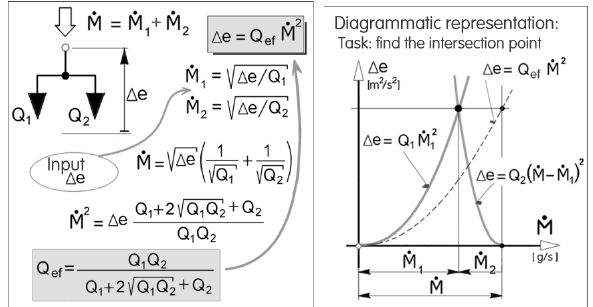
Fig. 11. An example of usefulness of nozzle characterisation by quadratic dissipances Q. For a given specific energy drop  e and dissipances Q 1 and Q 2 of the two nozzles the approach evaluates their mass flow rates. A useful step is to evaluate the effective dissipance Q ef of the unit consisting of the two